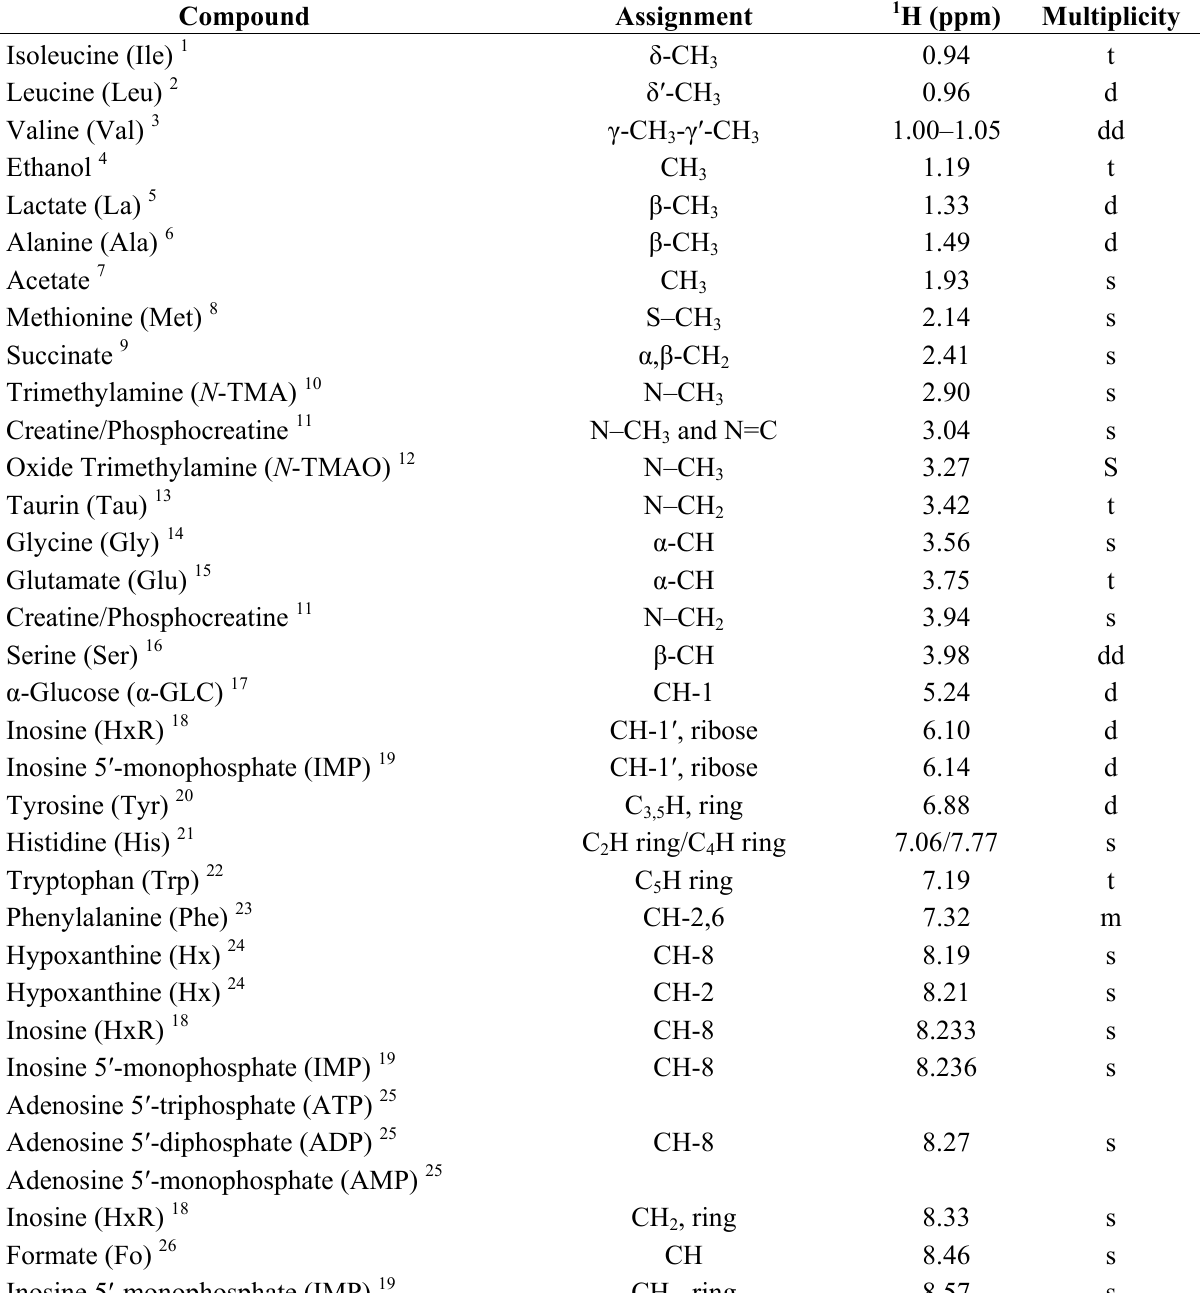
Table 1. Summary of the metabolites identified in the 600.13 MHz 1 H NMR spectrum of the aqueous extract of Bogue